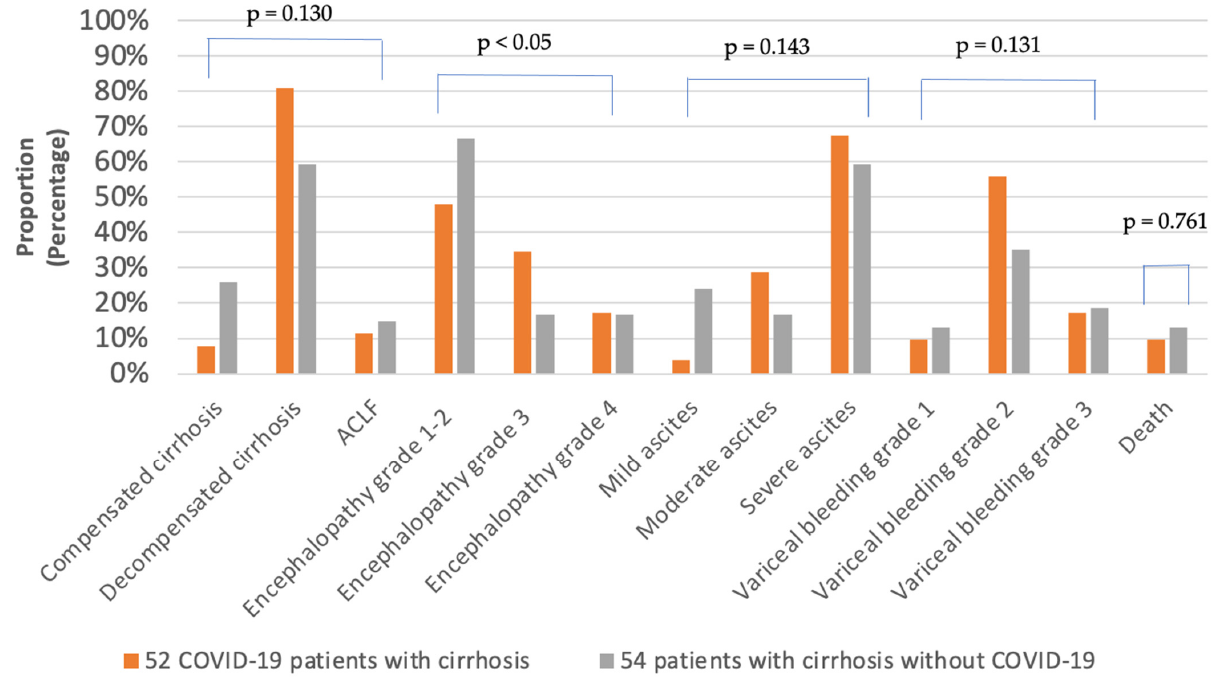
Figure 4. Clinical characteristics of patients with liver cirrhosis.